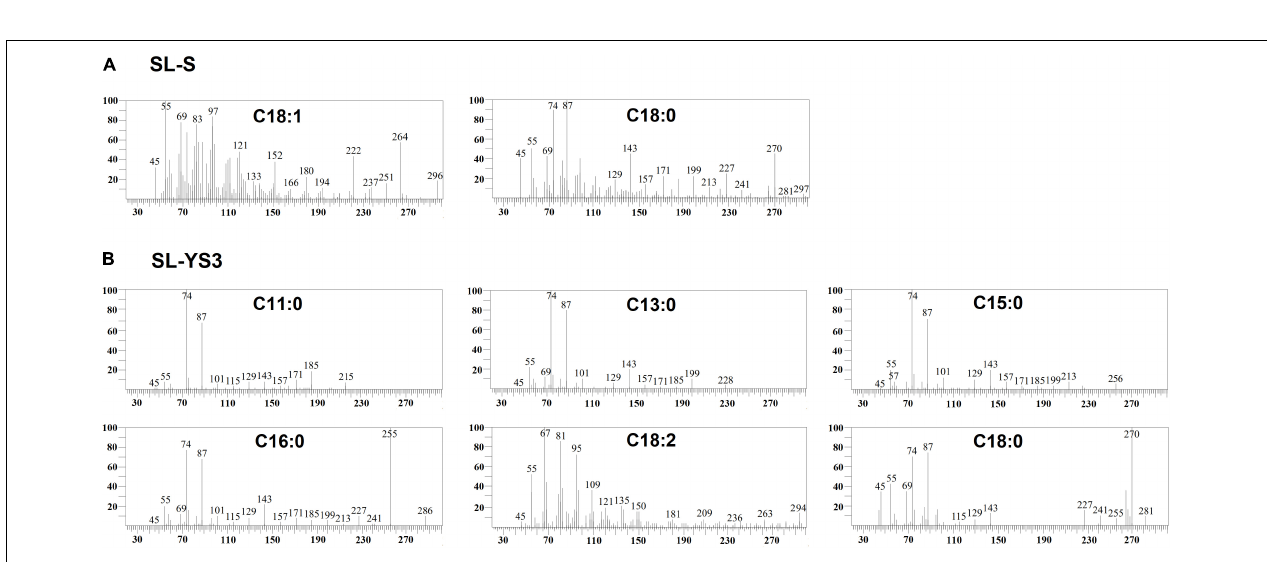
FIGURE 2 | Mass spectra of the fatty acids present in the constituent congeners derivatized to fatty acid methyl esters (FAMEs) (A) commercially available sophorolipid 1 (cid:48) ,4 (cid:48)(cid:48) -Sophorolactone 6 (cid:48) ,6 (cid:48)(cid:48) -diacetate (SL-S) (B) sophorolipid produced by R. babjevae YS3 (SL-YS3) as identified by GC–MS analysis.